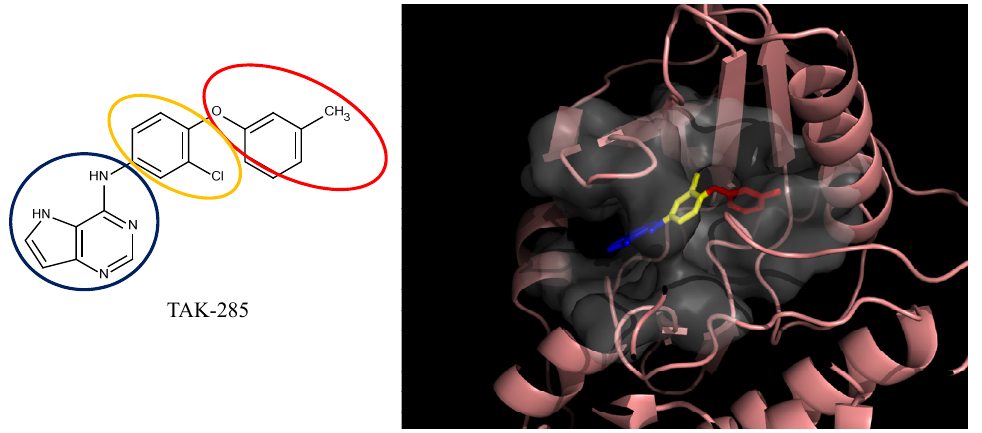
Figure 5. The compound 6m from the TAK-285 series docked with HER2 kinase (PDB ID: 3RCD). The ellipsoids define the portion of the compounds that interact with the HER2 binding site—ATP site (blue ellipsoid; fragment 1) and allosteric site (red ellipsoid; fragment 2)—while the linker is denoted with the orange ellipsoid. The cavity of HER2 is depicted as a gray surface with a bound inhibitor (tube). The inhibitor is represented in a similar fashion as the depicted compounds. The portions of the compound that interacts with the different regions of the binding site are color-coded. The portion that interacts with the ATP binding site is blue (fragment 1), the linker is yellow, and the allosteric site portion is red (fragment 2).